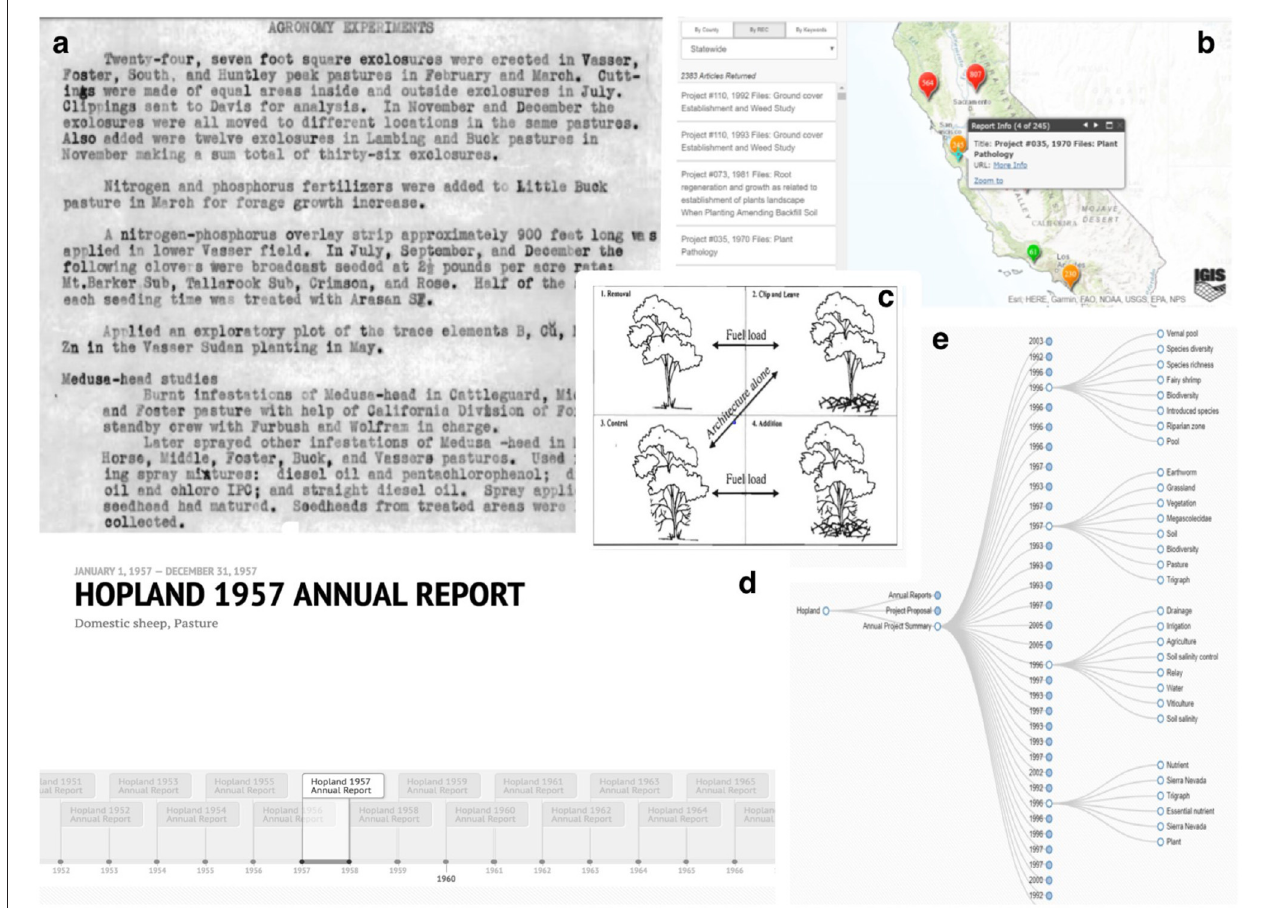
FIGURE 2 | Panel of images from the REC project: (a) example of an original research report; (b) Web mapping platform providing access to the original scanned PDF documents, searchable by REC, keywords, and date; (c) example of image from an original research report showing a fuel reduction experiment; (d) timeline visualization of researchers and topics conducted on Hopland REC; (e) interactive visualization of keywords extracted from research reports screenshot of the interactive website.